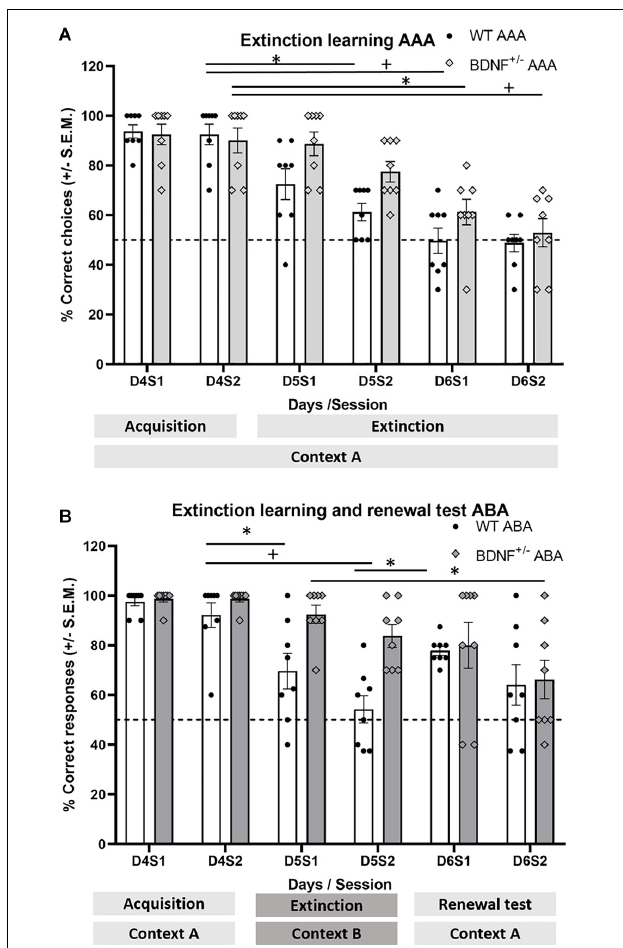
FIGURE 3 | significant impairment in extinction learning became evident in BDNF + / − mice compared to WT littermates (whereas WT mice exhibit performance differences between the end of acquisition, D4S2 to D5S1 and D5S2, BDNF + / − do not). Although WT mice exhibited significant renewal on Day 6 (correct choices during D6S1 compared to choices during D5S2), BDNF + / − mice displayed choice levels during D6S1, that were not different from choices made on Day 5, indicating that WT exhibited renewal. By contrast, BDNF + / − mice showed perseverance in entering the previously rewarded target arm. *( p ≤ 0.05) and + ( p ≤